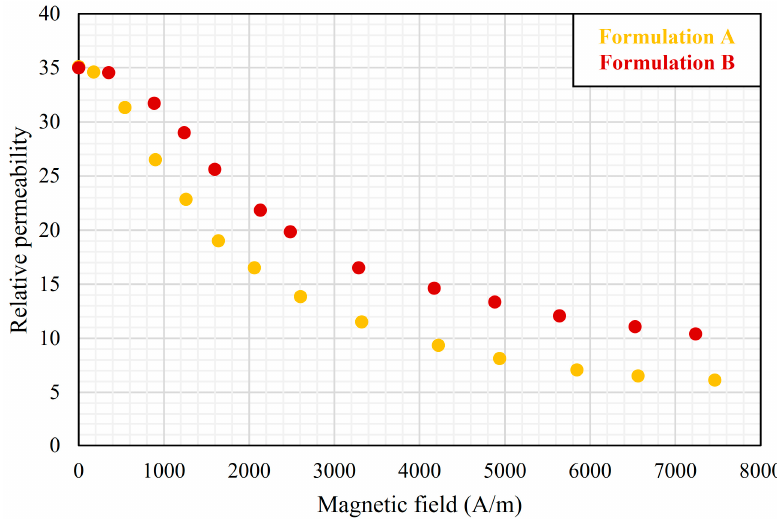
Figure 5. Plots of relative permeability versus DC magnetic field of Formulations A and B.